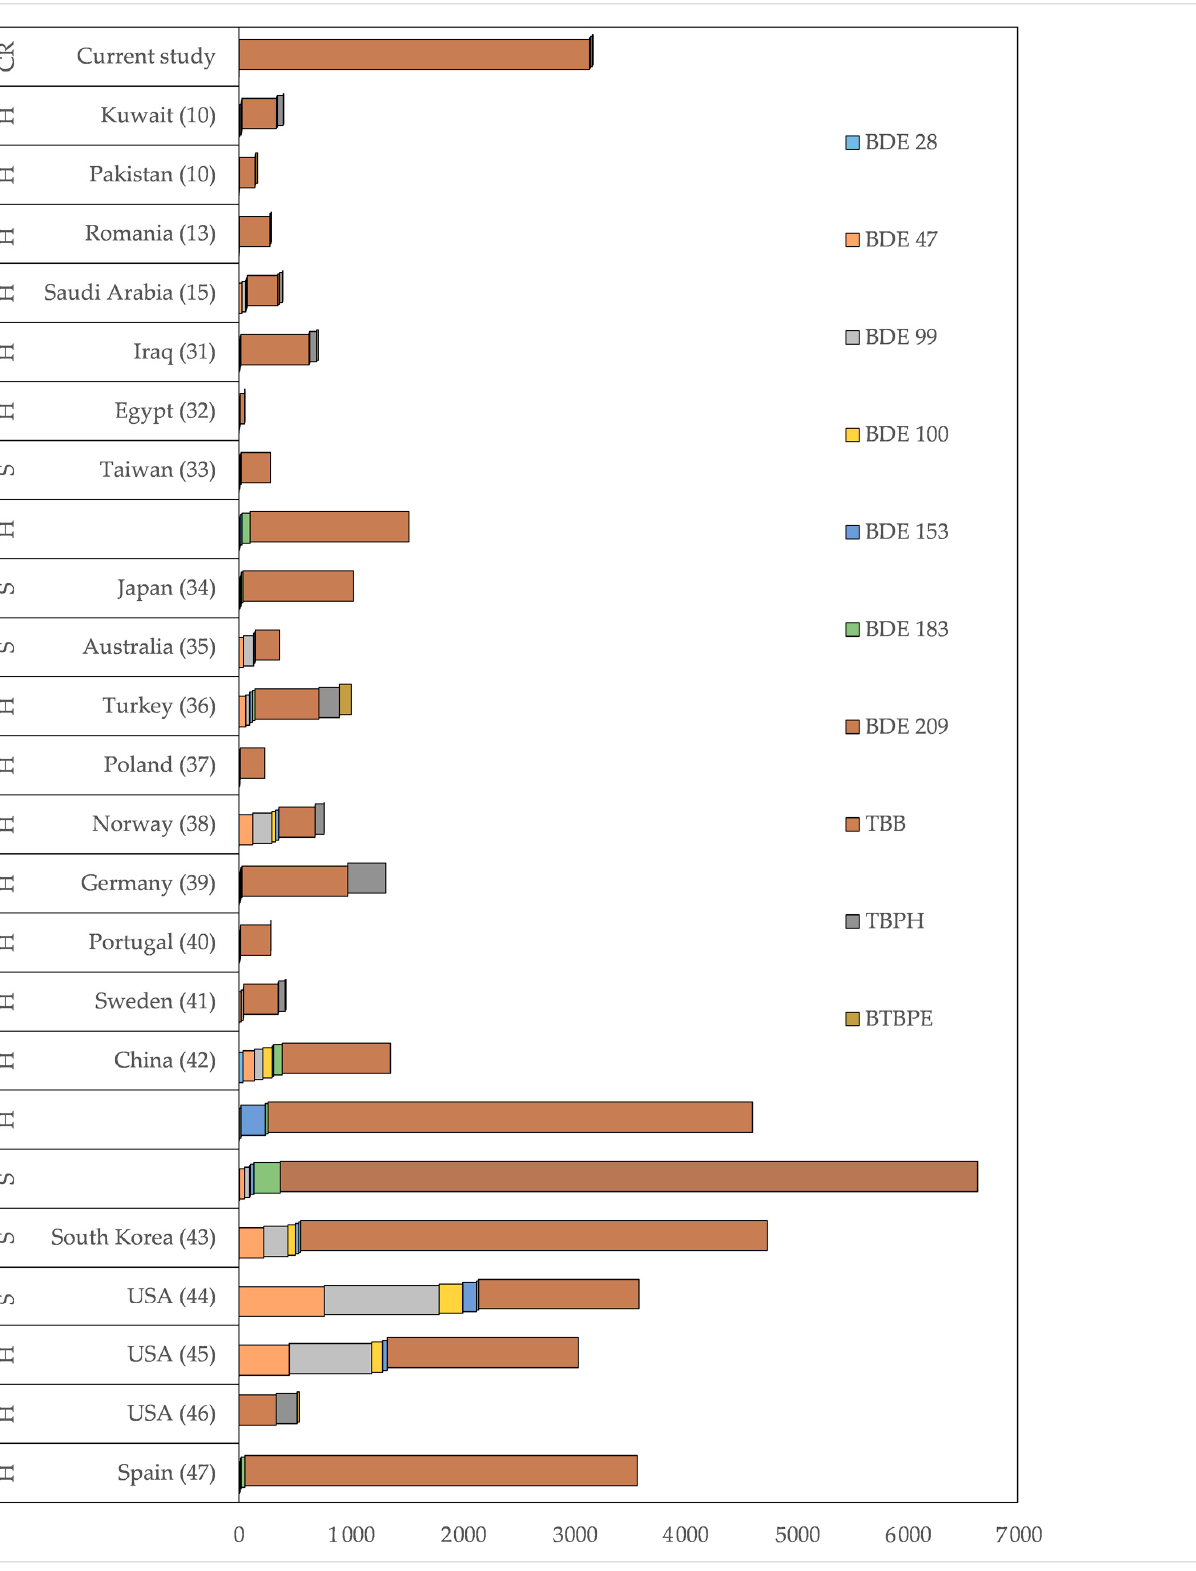
Figure 3. Comparison of median levels (ng/g) of BFR data from different countries for indoor dust. Values on the longitudinal axis are in ng/g. H, S, and CR represent household, school, and children’s rooms, respectively.